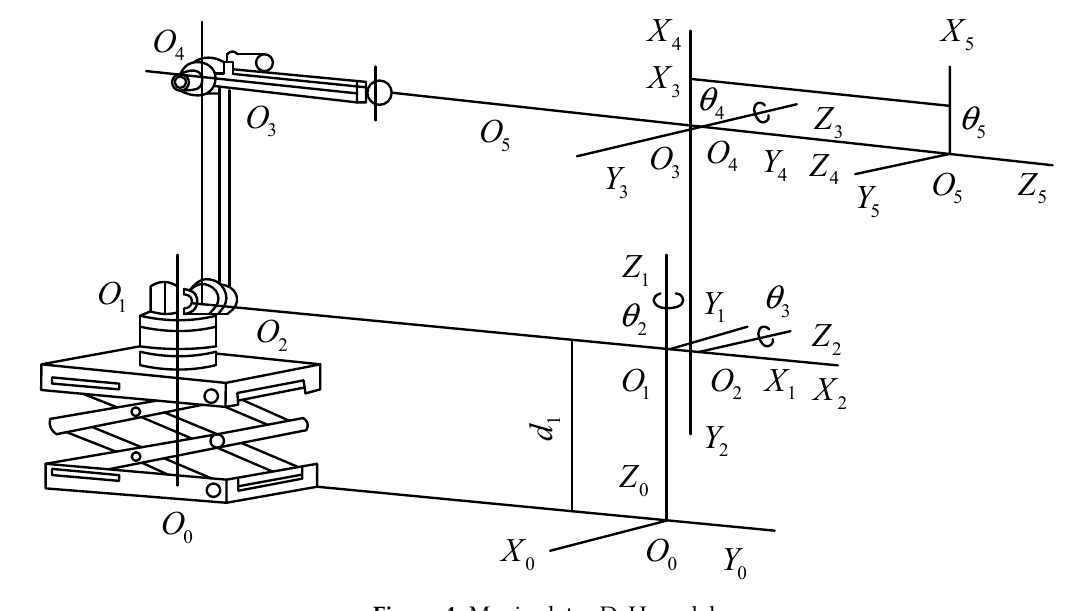
Figure 4. Manipulator D–H model.